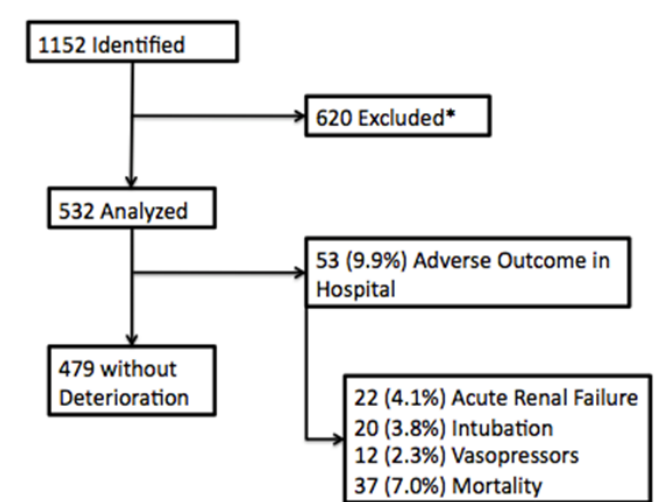
Figure 1. Flowchart of study enrollment, exclusions, and primary outcome. *See Supplemental Table 1 for rates of exclusion by